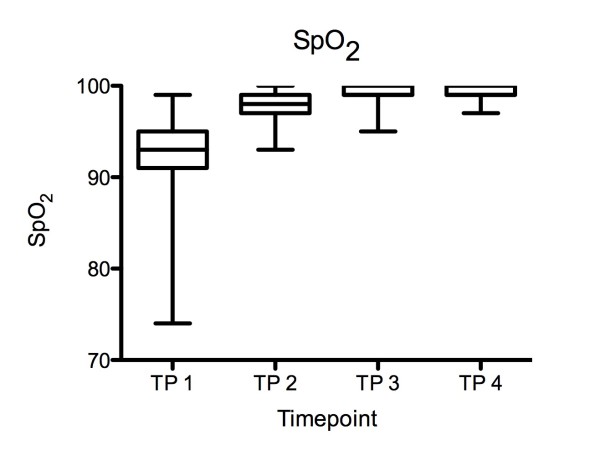
Oxygen saturation [SpO2] during tracheal intubation: After initial pre-oxygenation and bag valve ventilation (T2), SpO2 remained stable at T3 and T4. Data are means +/- standard deviation.